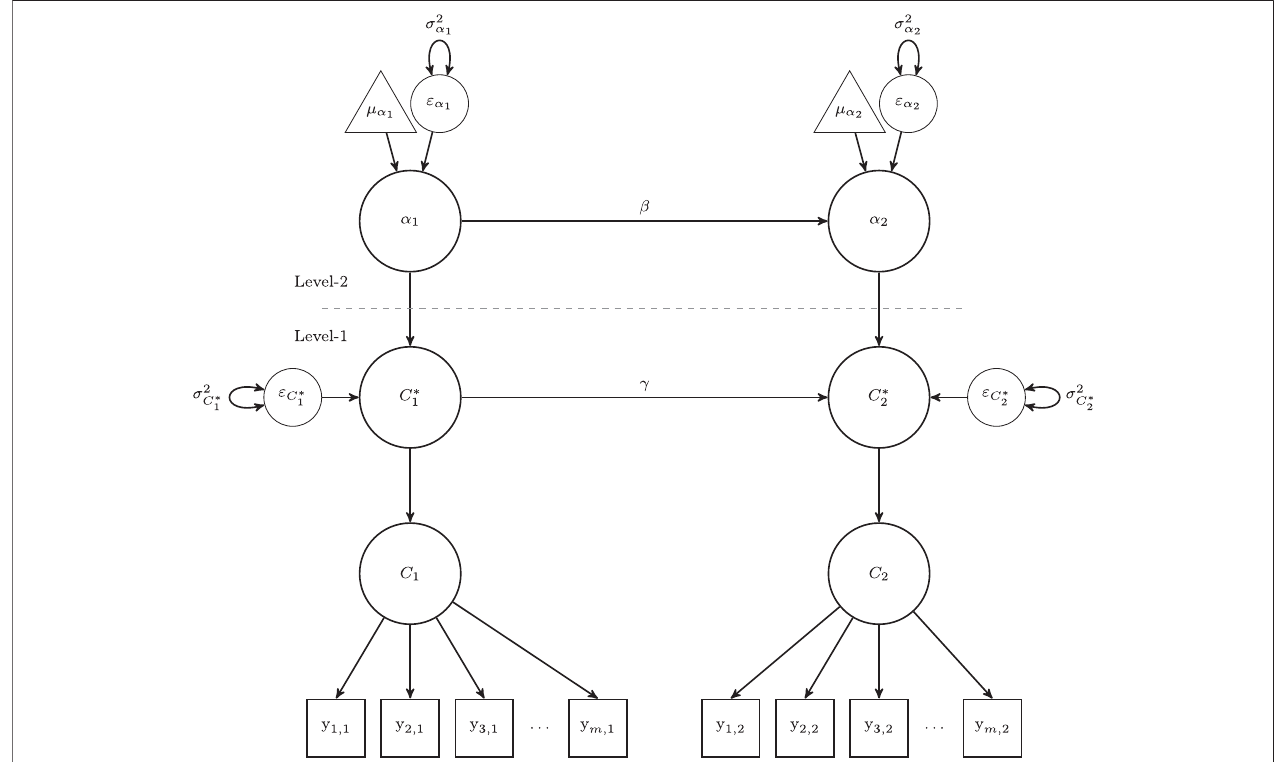
FIGURE1| PathdiagramofamultilevellatenttransitionmodelproposedforECLS-KSocialRatingScaleovertwowaves.Note.Subscriptsindicatethetimepointof thedata.AtL (cid:2) ApproachestoLearning;SC (cid:2) Self-control;IPS (cid:2) InterpersonalSkills;EPB (cid:2) ExternalizingProblemBehaviors;IPB (cid:2) InternalizingProblemBehaviors; α t (cid:2) random intercept for time t, so α 1 is the random intercept time 1; C t (cid:2) latent class at time t, which takes on values C t (cid:2) 1 , 2 (For ease of notation, let c (cid:2) 1 , 2 represent latent class at time 1 and let d (cid:2) 1 , 2 be the latent class at time 2); β (cid:2) the regression weight associated of random effect at time 1 predicting the random effect at time 2; c (cid:2) the change in logits of the latent response tendency variable at time 2 for individuals in class 1 at time 1 ( c only applied to cases that are in class 1 at time 1 which is captured by using an indicator function I ( C 1 (cid:2) 1 ) which is a Bernoulli random variable); the residual variance of the level-1 latent response tendency variable (cid:2) 3 . 29 which is the variance of the logistic distribution. relative to the reference class, C * t is π 2 3